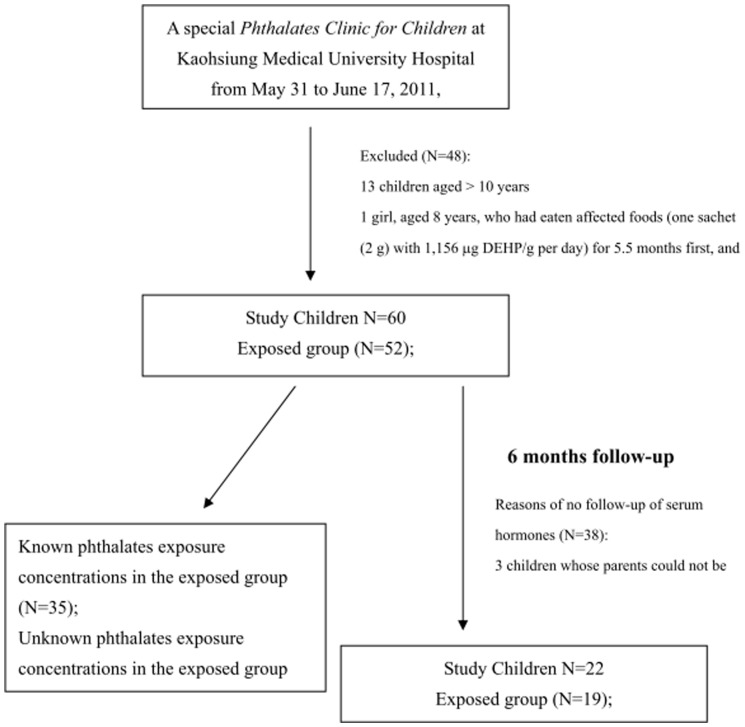
Flow chart of this study (known phthalate concentrations of affected foods were obtained from two sources: the official website of Taiwan Food and Drugs Administration and the Kaohsiung City Bureau of Health (Wu et al., 2012)).